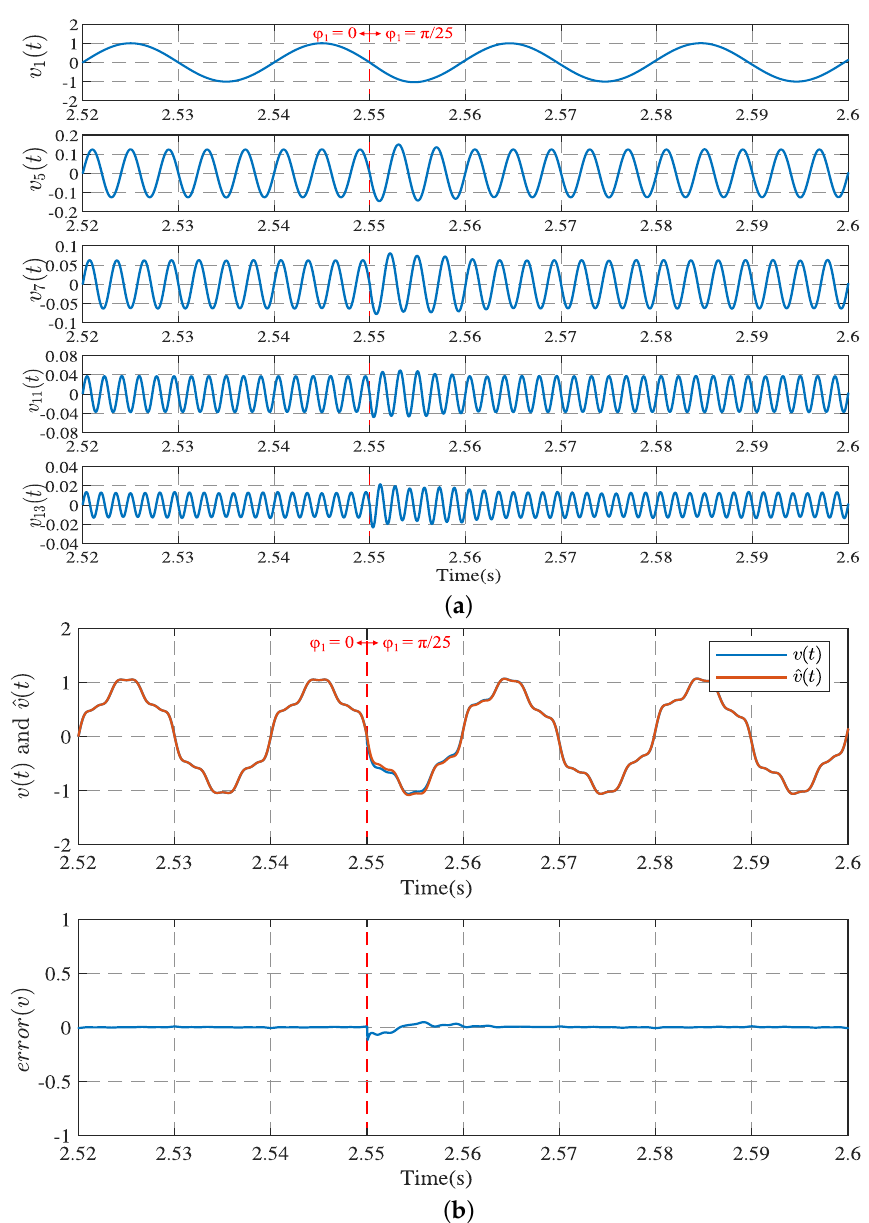
Figure 8. Real-time simulation results: ( a ) The effect of extracting each harmonic after the phase angle jump of the fundamental of the input signal; ( b ) Comparison of the observer results with the real signal and the error curve. The simulation waveform for case 4 is shown in Figure